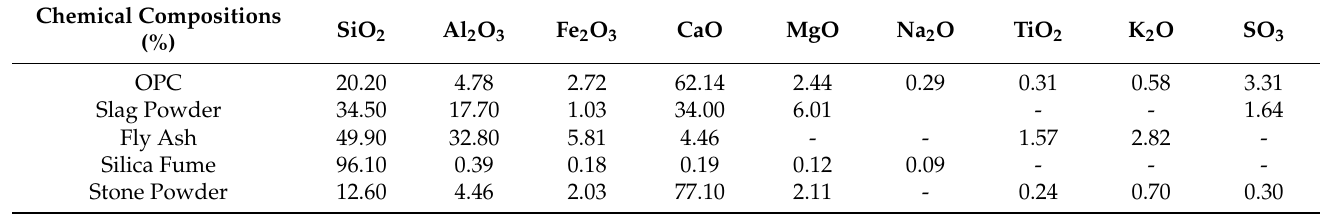
Figure 3. Raw materials: ( a ) fly Ash, ( b ) slag Powder, ( c ) silica Fume, and ( d ) stone Powder. Table 1. Main properties of cement and silica fume.